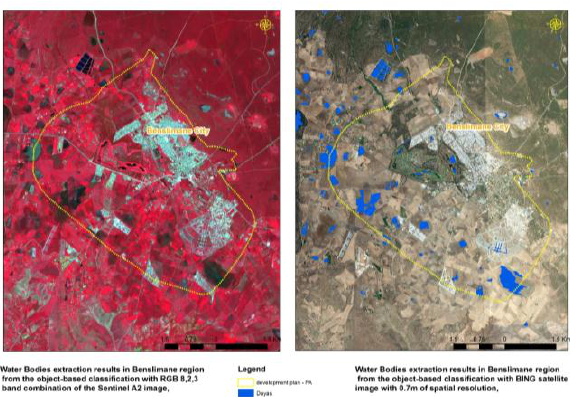
Figure 6. Extraction of dayas by the object-oriented approach As for the object-oriented classification, it gave better results in precision analysis and showed no fuzzy or inaccurate information that could distort the result of the classification.